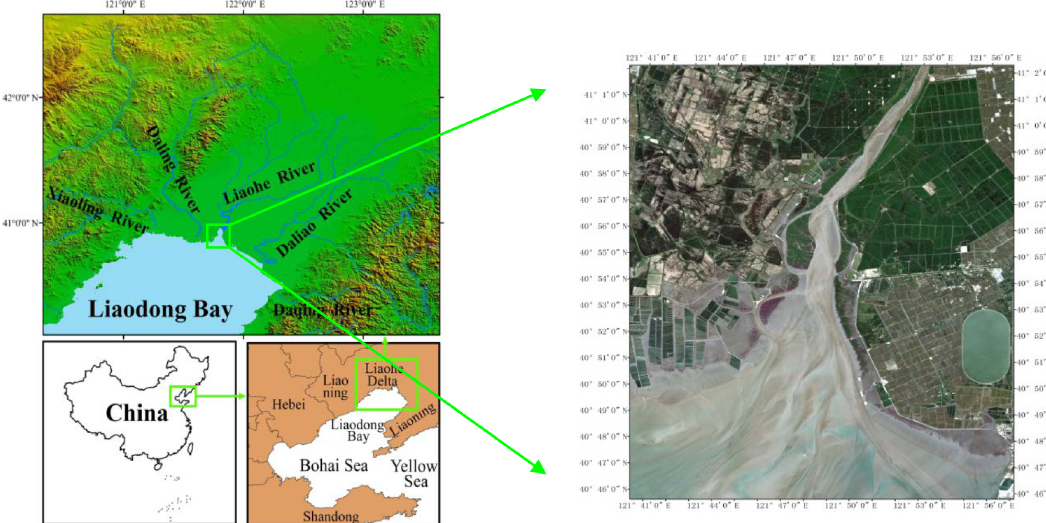
Figure 2. The geographical location (Wang et al., 2017) and satellite image of the Liao River estuary.